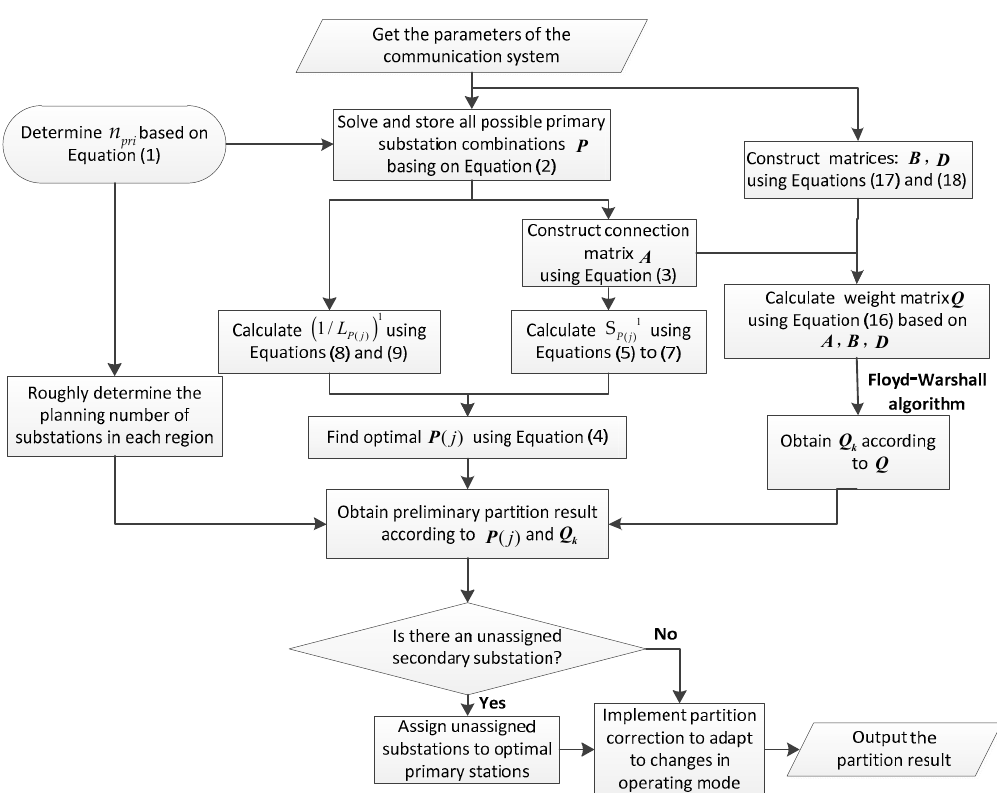
Figure A1. The processes of the regional protection partition strategy considering all communication constraints, such as the lengths and bandwidths of channels.